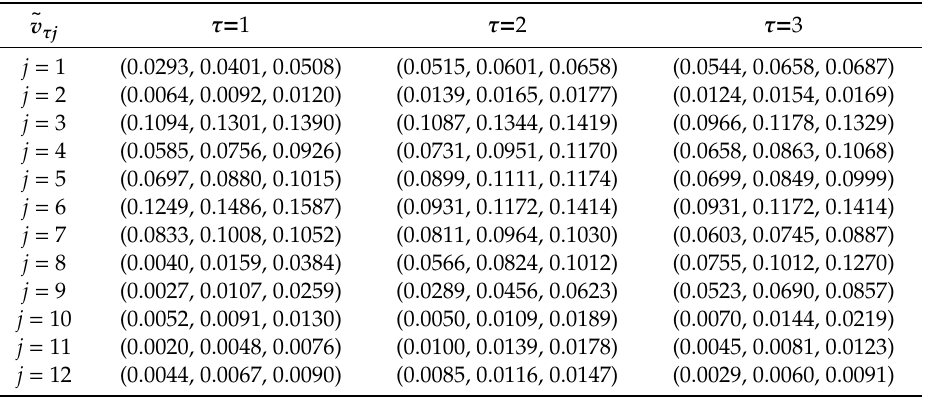
Table 11. Weighted normalized fuzzy decision matrix.